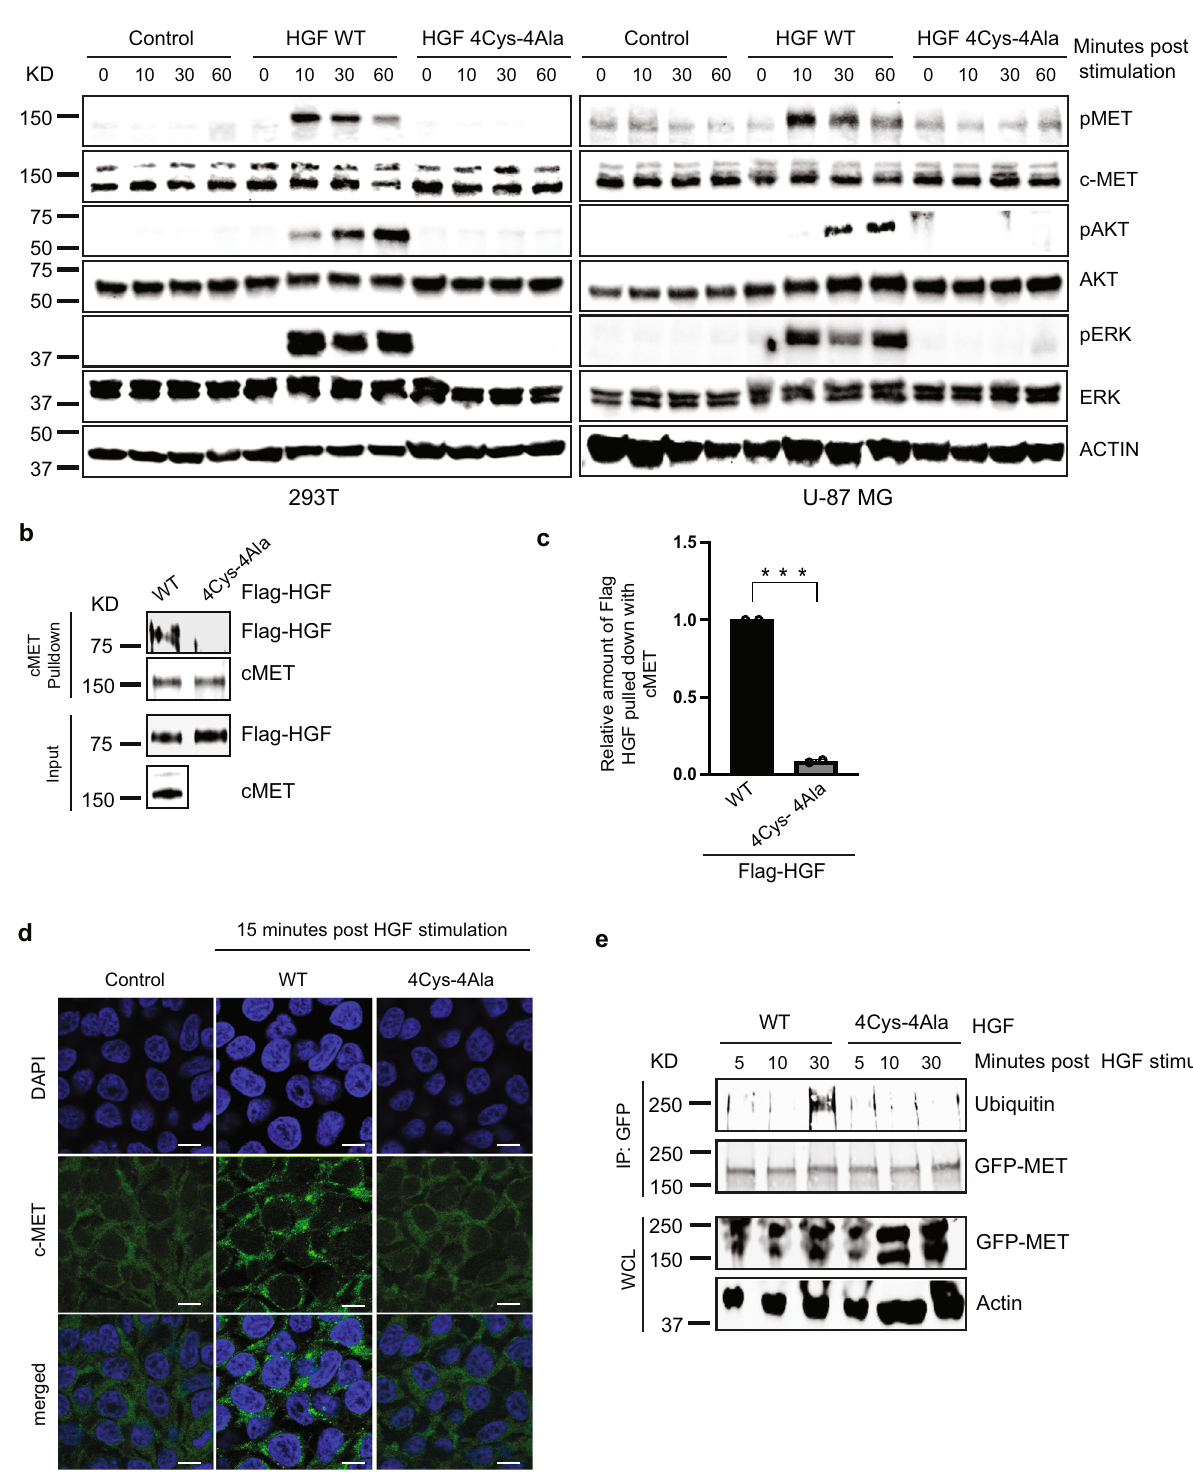
Activated puri fi ed biotinylated HGF WT protein and HGF 4Cys-4Ala protein were incubated with GFP-c-MET expressing cell lysate in the dark for 45 min, and crosslinking was induced by UV irradiation. After crosslinking, biotin-containing complexes were immunoprecipitated on streptavidin beads and analyzed by Western blotting for the presence of GFP-c-MET. As shown